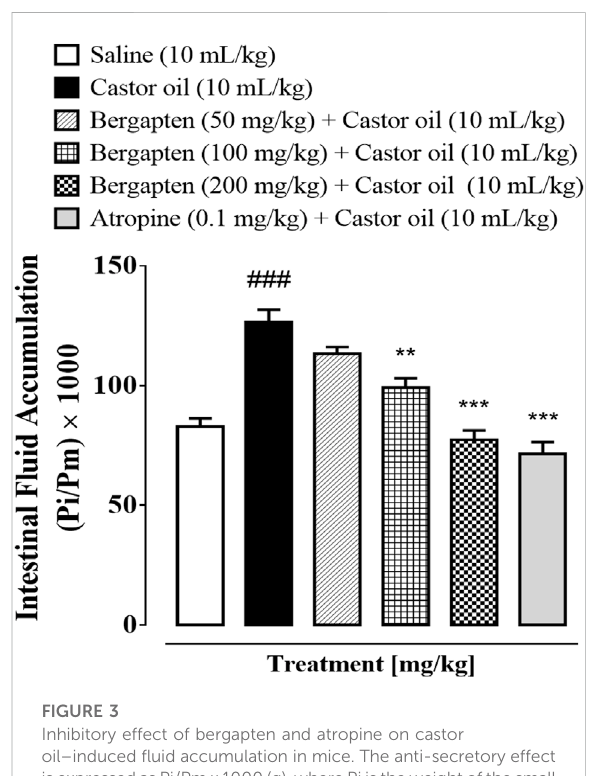
FIGURE 3 Inhibitory effect of bergapten and atropine on castor oil – induced fl uid accumulation in mice. The anti-secretory effect isexpressedasPi/Pmx1000(g),wherePiistheweightofthesmall intestine and Pm is the weight of mouse. Results are expressed as mean ± SEM, n = 5. One-way analysis of variance with post hoc Tukey ’ s test. ### p < 0.001 vs. saline group, ** p < 0.01 vs. castor oil group, *** p < 0.001 vs. castor oil